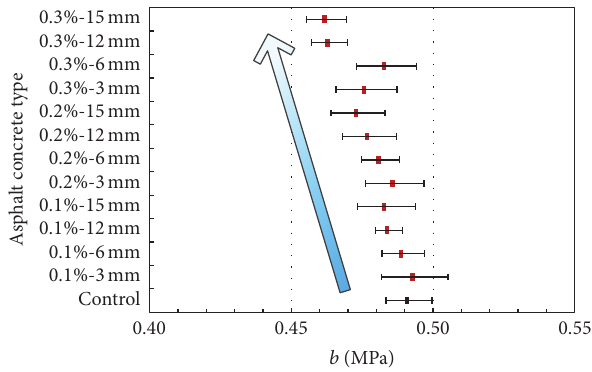
Figure 9: Parameter 𝑏 for different asphalt concrete.